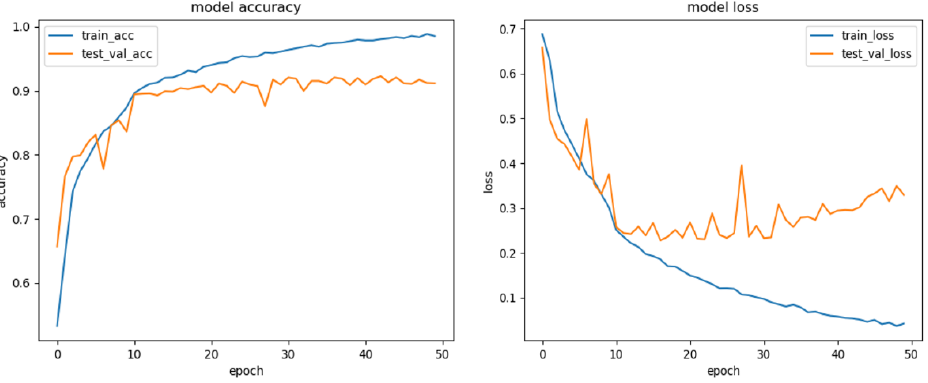
Figure 2. The model accuracy and the model loss of the BERT method. In the model accuracy distribution map, train_acc denotes the correct rate of the training set and test_val_acc is the correct rate of the test set. After 50 training runs, the highest correct rate in the experimental result is